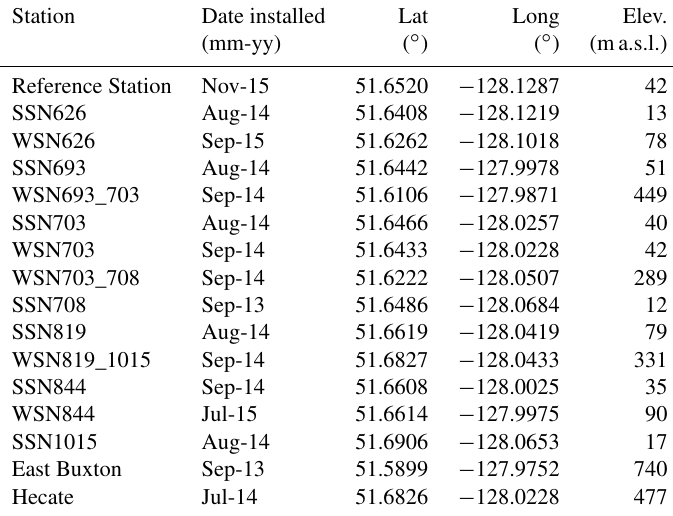
Table A1. Station location and installation details. Station names refer to stream sensor node (SSN) or weather sensor node (WSN), followed by the watershed ID, and are ordered by location (west to east on Calvert and then Hecate islands). Reference Station and East Buxton are located outside watershed boundaries and Hecate is located at the boundary of watersheds 819 and 844 (Fig. 1). Station Date installed